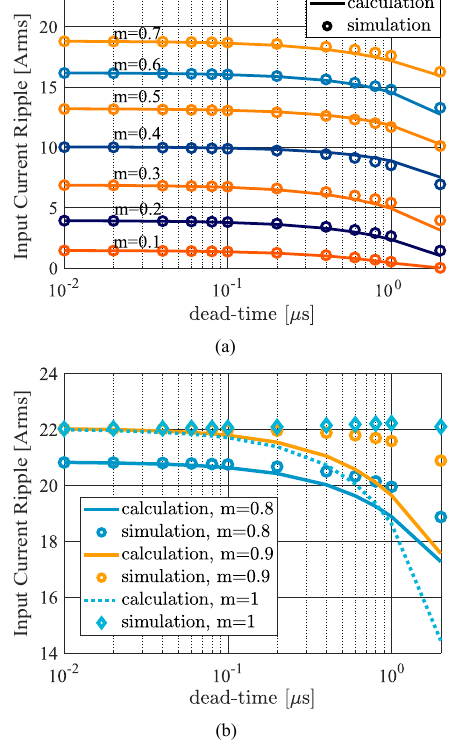
Figure 6. Calculation and simulation results of dead-time vs. rms input current ripple of the three- phase VSI (case 1 load) for ( a ) 0.1 ≤ m ≤ 0.7; ( b ) 0.8 ≤ m ≤